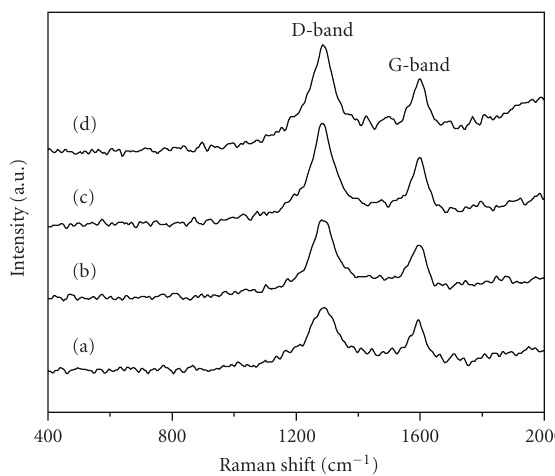
Figure 6: Raman spectra of purified multiwalled CNTs for (a) 50% Co, (b) 25% Co + 25% Ni, (c) 20% Co + 30% Ni, and (d) 50% Ni on MgO